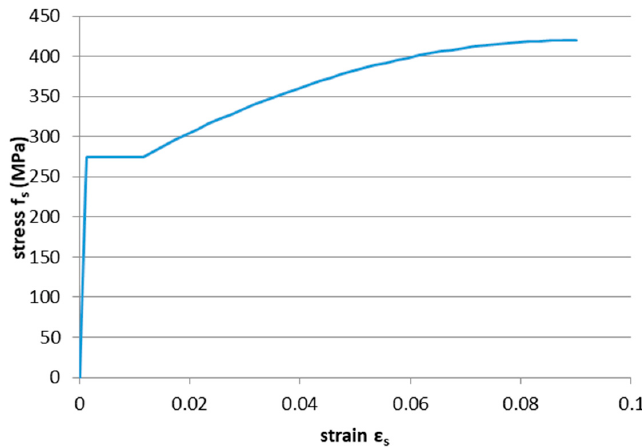
Figure 3. Stress–strain curve of a steel bar used in this study.